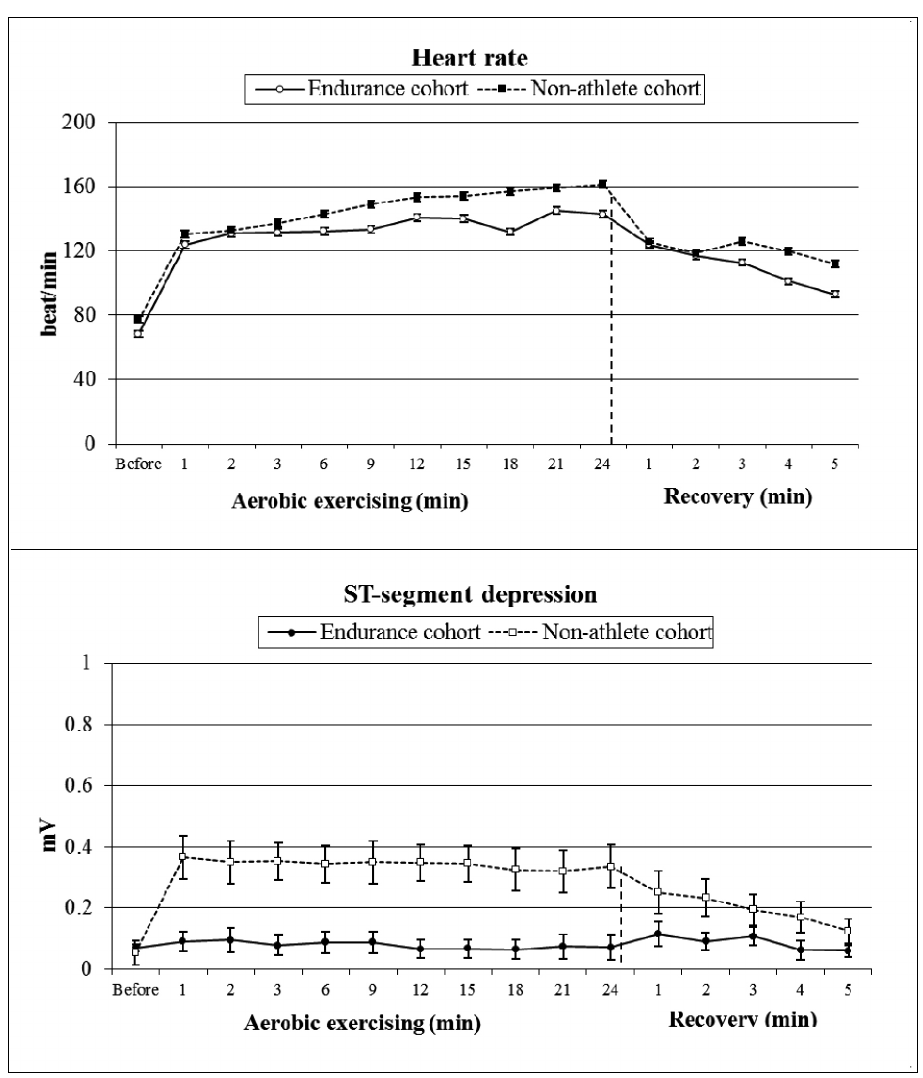
Figure 3. Dynamics of HR and ST-segment depres - sion during the continuous aerobic exercising and re -